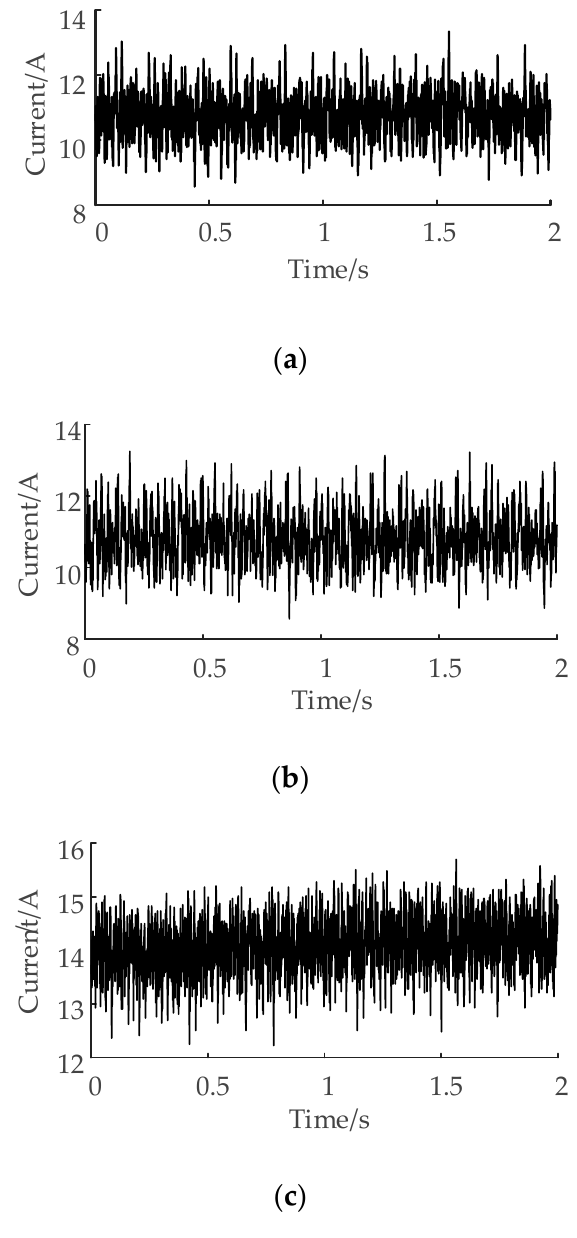
Figure 3. ( a ) Time–domain waveform of the current signal at the initial tool wear stage, ( b ) time–domain waveform of the current signal at the normal tool wear stage, and ( c ) time–domain waveform of the current signal at the sharp tool wear stage.